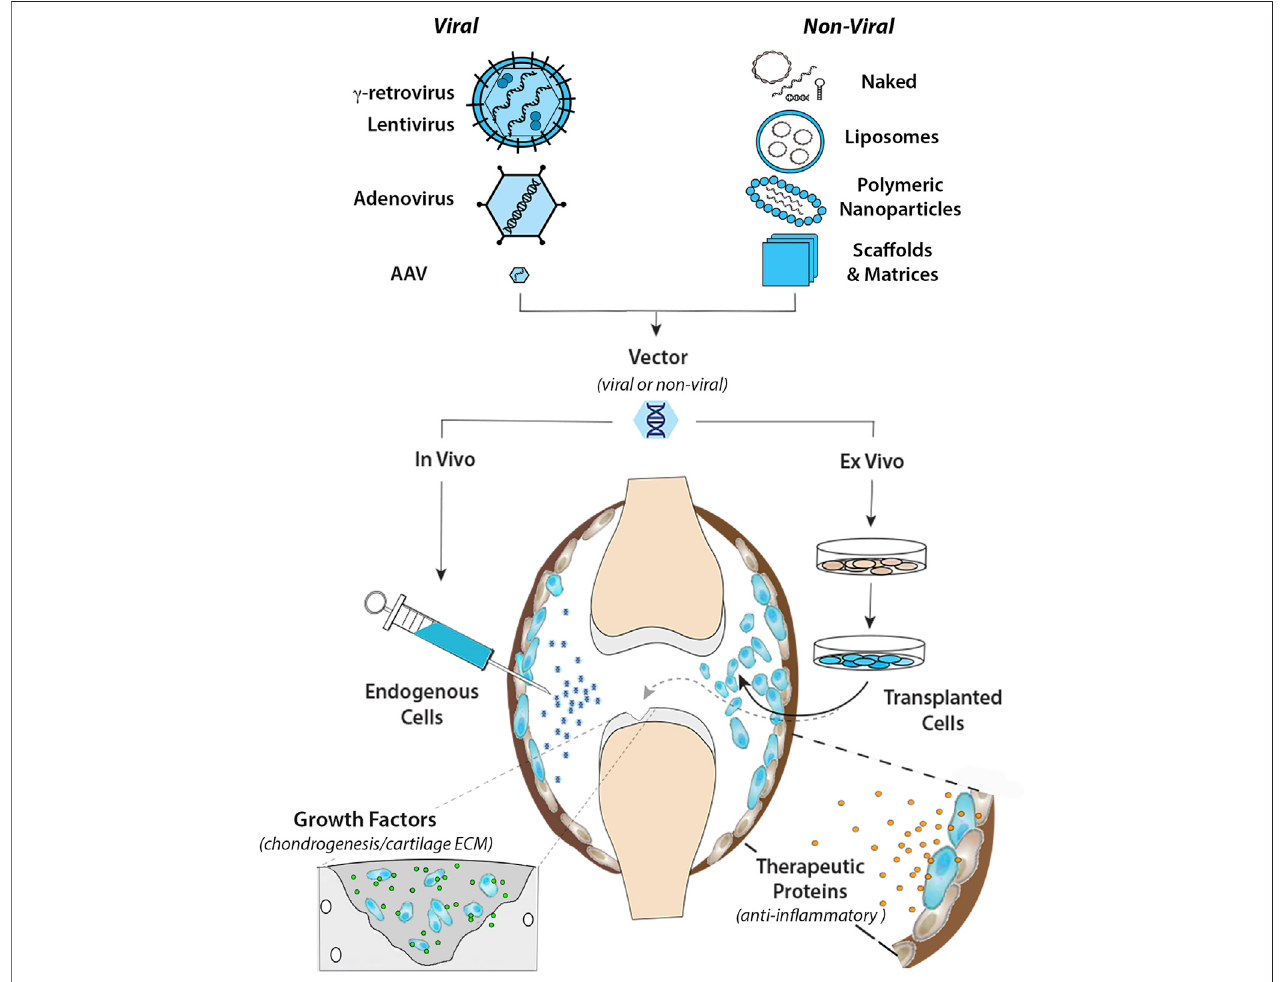
FIGURE 1 | Intra-articular gene transfer- an archetypical model for orthopaedic gene therapy. (Top) Experimental strategies for delivery of therapeutic genes and nucleic acids to diseased or damaged tissues involve a variety of Viral and Non-Viral vector systems. The graphic on the left illustrates the basic structural and physical properties ofthe most widely used viral vector systems. The Retroviruses( γ -retrovirus and lentivirus) are relatively large (~100 nm dia) enveloped viruses that “ bud ” from the surface of the infected cell. The outer envelope is composed of lipid bilayer acquired from the plasma membrane of the host cell during viral escape. Retroviral env (or VSV-G for pseudotyped virus) glycoprotein molecules transverse the outer envelope and are used for viral attachment to target cells. Two + strand copies of the RNAgenomeareencasedintheprotectivenucleocapsidalongwithreversetranscriptaseandintegraseproteinsthatconverttheRNAgenometoDNAandintegratethe provirus into the host genome. Adenovirus is a non-enveloped virus that replicates by lytic infection. The viral capsid is an icosahedron ~90 – 100 nm in diameter that encases alinear dsDNA genome.Adenoviral fi ber/knob complexes protrude from each ofthe12 vertices of theicosahedronand are used for attachment totarget cells. Following entry into the nucleus, the viral DNA remains episomal. Adeno-associated virus (AAV) is a comparatively simple, small non-enveloped, iscosahedral virus, ~20 nm in diameter. The viral capsid houses a short (~4.7 bp) ssDNA genome. Following infection, the genome is maintained episomally in concatemers formed by intermolecular recombination (Yang et al., 1999). Due to their inherent differences in biology and physical properties each viral vector is best suited to different types of applications and delivery strategies. To bypass the need for viruses for gene delivery, a wide range of non-viral systems (shown in the graphic on the right) are under investigation for their utility in orthopaedic applications. These non-viral systems utilize to varying extents, chemical modi fi cation of plasmid DNAs, soluble mRNAs, and RNAimolecules, which canbe delivered “ naked ” in soluble form, orcomplexedwithcationic lipidsasliposomesor various polymers intonanoparticlestocondense and protect the nucleic acids from degradation, prevent electrostatic repulsion and facilitate cellular uptake. Various carrier scaffolds and matrices are often employed to aid and prolong delivery to target cells. (Bottom) Once incorporated in an appropriate vector, the therapeutic gene or nucleic acid can be delivered to diseased or damaged tissues by either in vivo or ex vivo methods. For in vivo delivery, the vector is administered directly to tissues at the relevant site to modify the resident cell populations in situ . In the present example, the vector is injected intra-articularly into the synovial fl uid of an arthritic joint to diffuse throughout the joint cavity and modify endogenous cells in the synovial lining (shown in blue) and/or articular cartilage. For ex vivo delivery, the vector is used to modify cells growing in culture, which can be administered locally to the site of disease or injury by different routes depending on the application. As indicated by the black arrow, the modi fi ed cells can be injected into the joint (or other relevant site) as a cellular suspension, to disperse and engraft in the local tissuesto continuously express and secrete a therapeutic gene product (e.g., IL-1Ra, IL- 10 etc.) into the local fl uids and tissues to inhibit in fl ammatory signaling for an extended duration (right-hand inset). Alternatively, the modi fi ed cells can be incorporated intoasupport matrixand surgicallyimplanted intoafocal cartilagelesion (orotherdamagedtissue)(dashed grayarrow). Followingdelivery,themodi fi edcellscontinually release speci fi c growth factors to stimulate chondrogenic differentiation and cartilage matrix synthesis to facilitate repair by both the local and implanted cell populations (left-hand